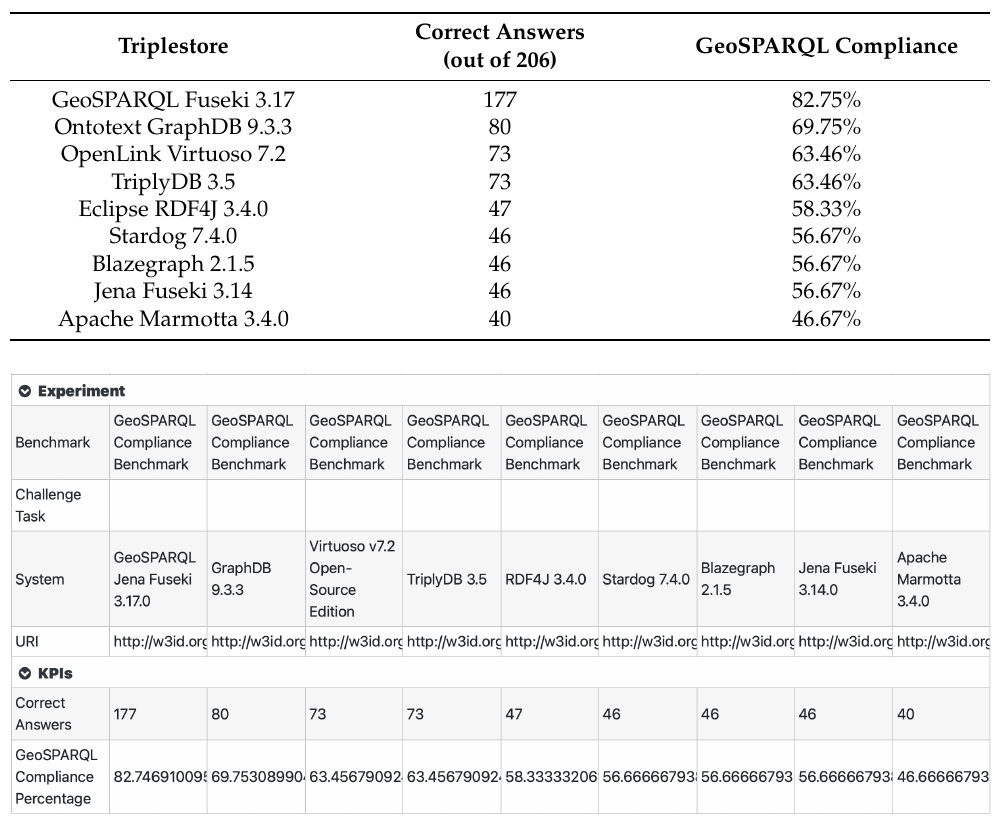
Table 2. Results from the GeoSPARQL compliance benchmark.